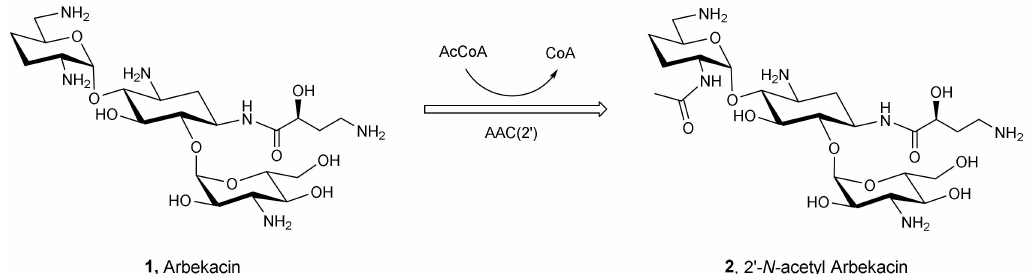
Figure 1. Schematic illustration for the action of AAC(2 (cid:48) ) on